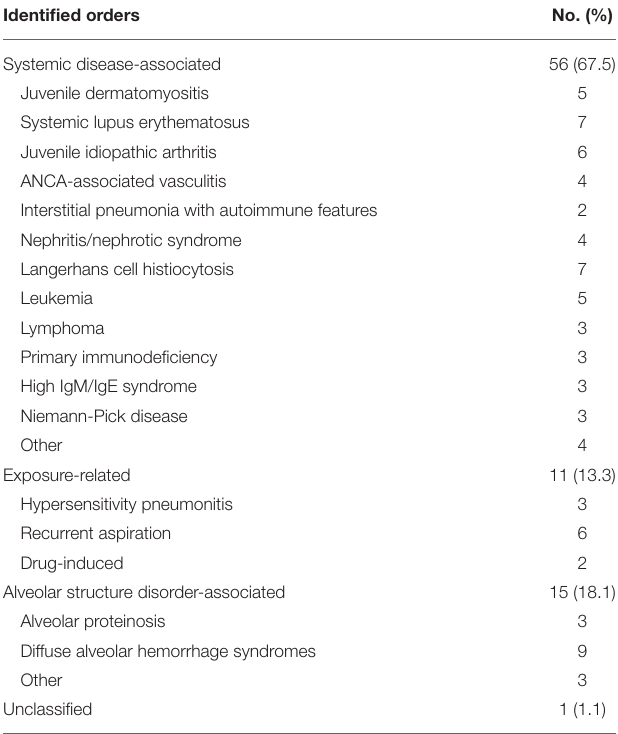
TABLE 2 | Etiology of children with diffuse radiological changes. Identified orders